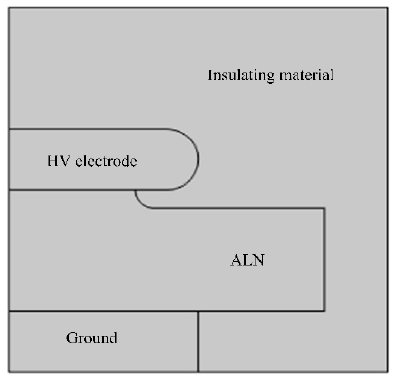
Figure 7. Simulation model. Table 8. Electrical parameters used in the simulation.